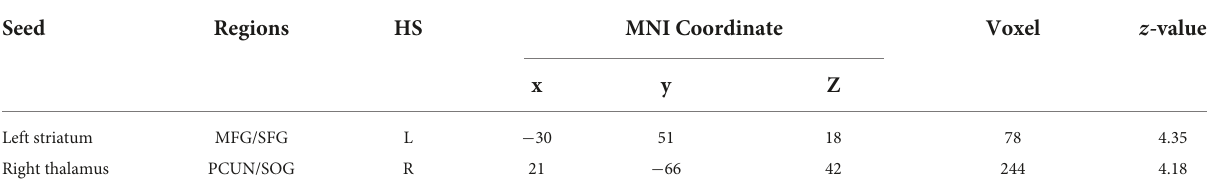
TABLE 2 Seed-based functional connectivity related to